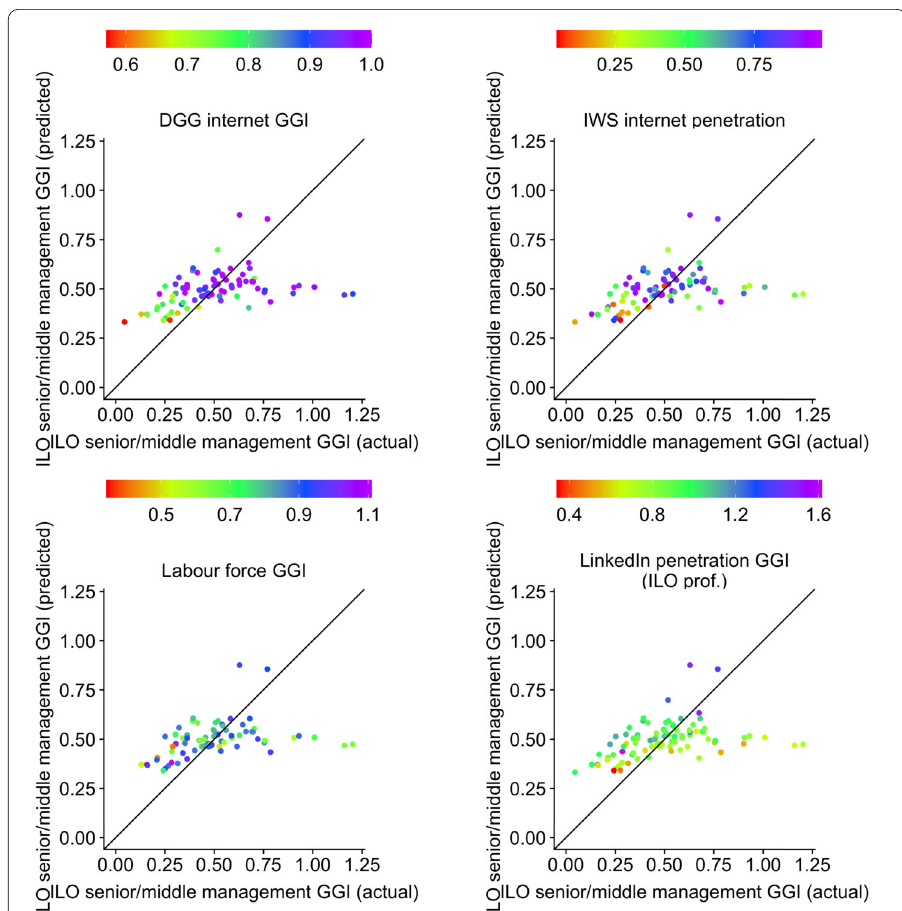
Figure 9 Scatter plot of ILO senior/middle management GGI (actual) ( x -axis) and ILO senior/middle management GGI (predicted) ( y -axis). Points in each panel are colour coded by values of the variable